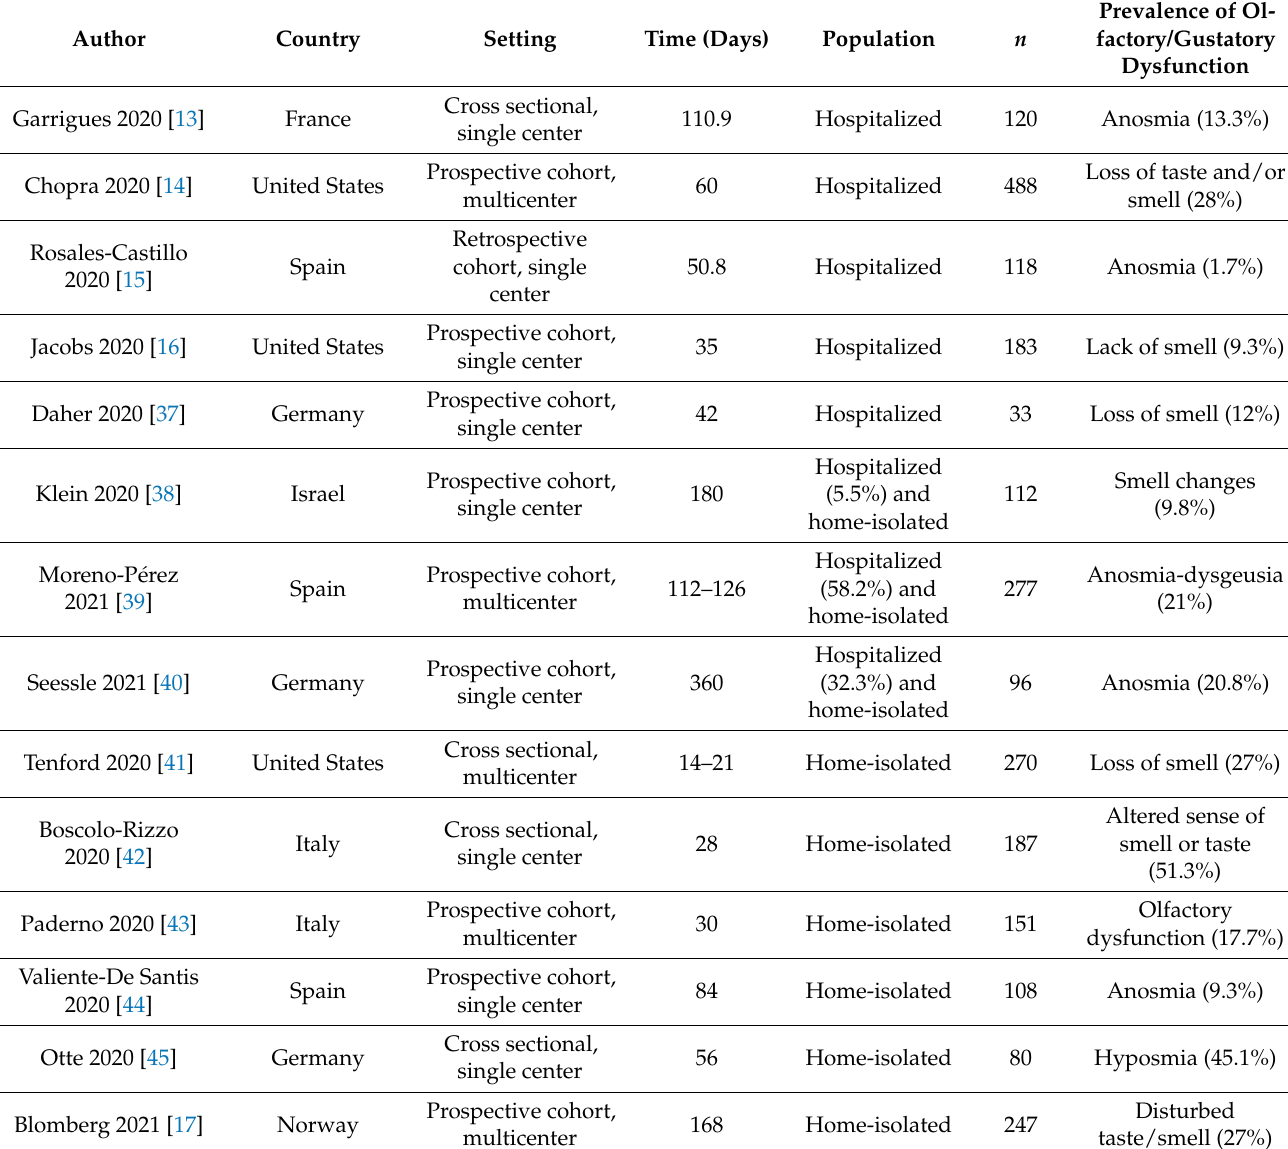
Table 1. Prevalence of olfactory dysfunction in post-acute COVID-19